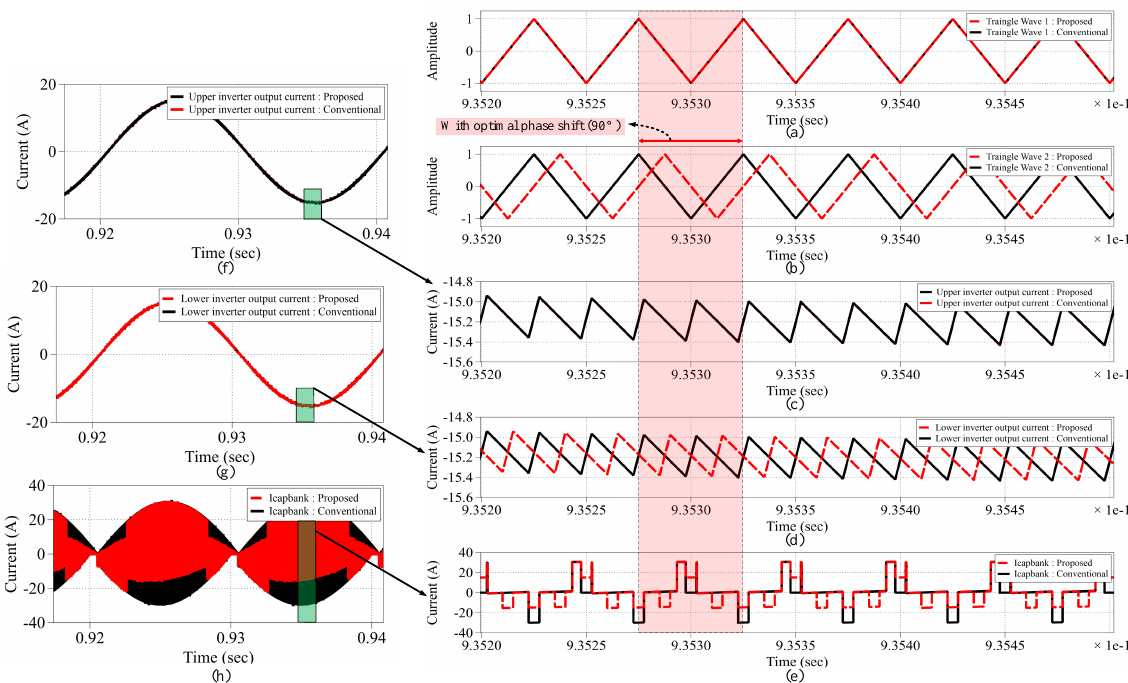
Figure 8. Red lines (proposed method with optimal phase-shift) and black lines (without any phase-shift ): ( a ) upper inverter carrier wave, ( b ) lower inverter carrier wave, output current ripple of: ( c ) upper inverter, and ( d ) lower inverter, ( e ) total DC-capacitor current ripple, the time-domain waveform of output current from the: ( f ) upper inverter and ( g ) lower inverter, ( h ) total DC-capacitor current